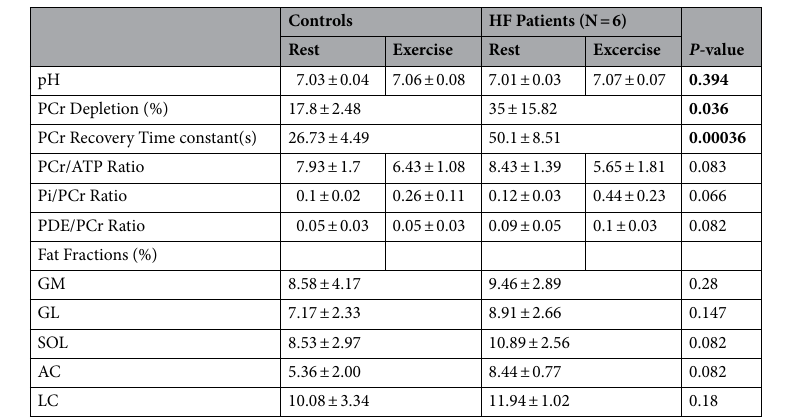
Table 1. Quantification and comparison of the subject cohorts between rest and exercise from 31 P-MRS and fat fraction. The table shows quantified parameters between controls and the HF patient cohort for change between rest and exercise conditions. The P -value calculated is a one-tailed T -test, with a significance threshold of 0.05. The pH variation between rest and exercise for both cohorts was not significant ( P = 0.394), while the PCr depletion in the HF patients following exercise was significantly higher ( P = 0.036). Bold font highlights important